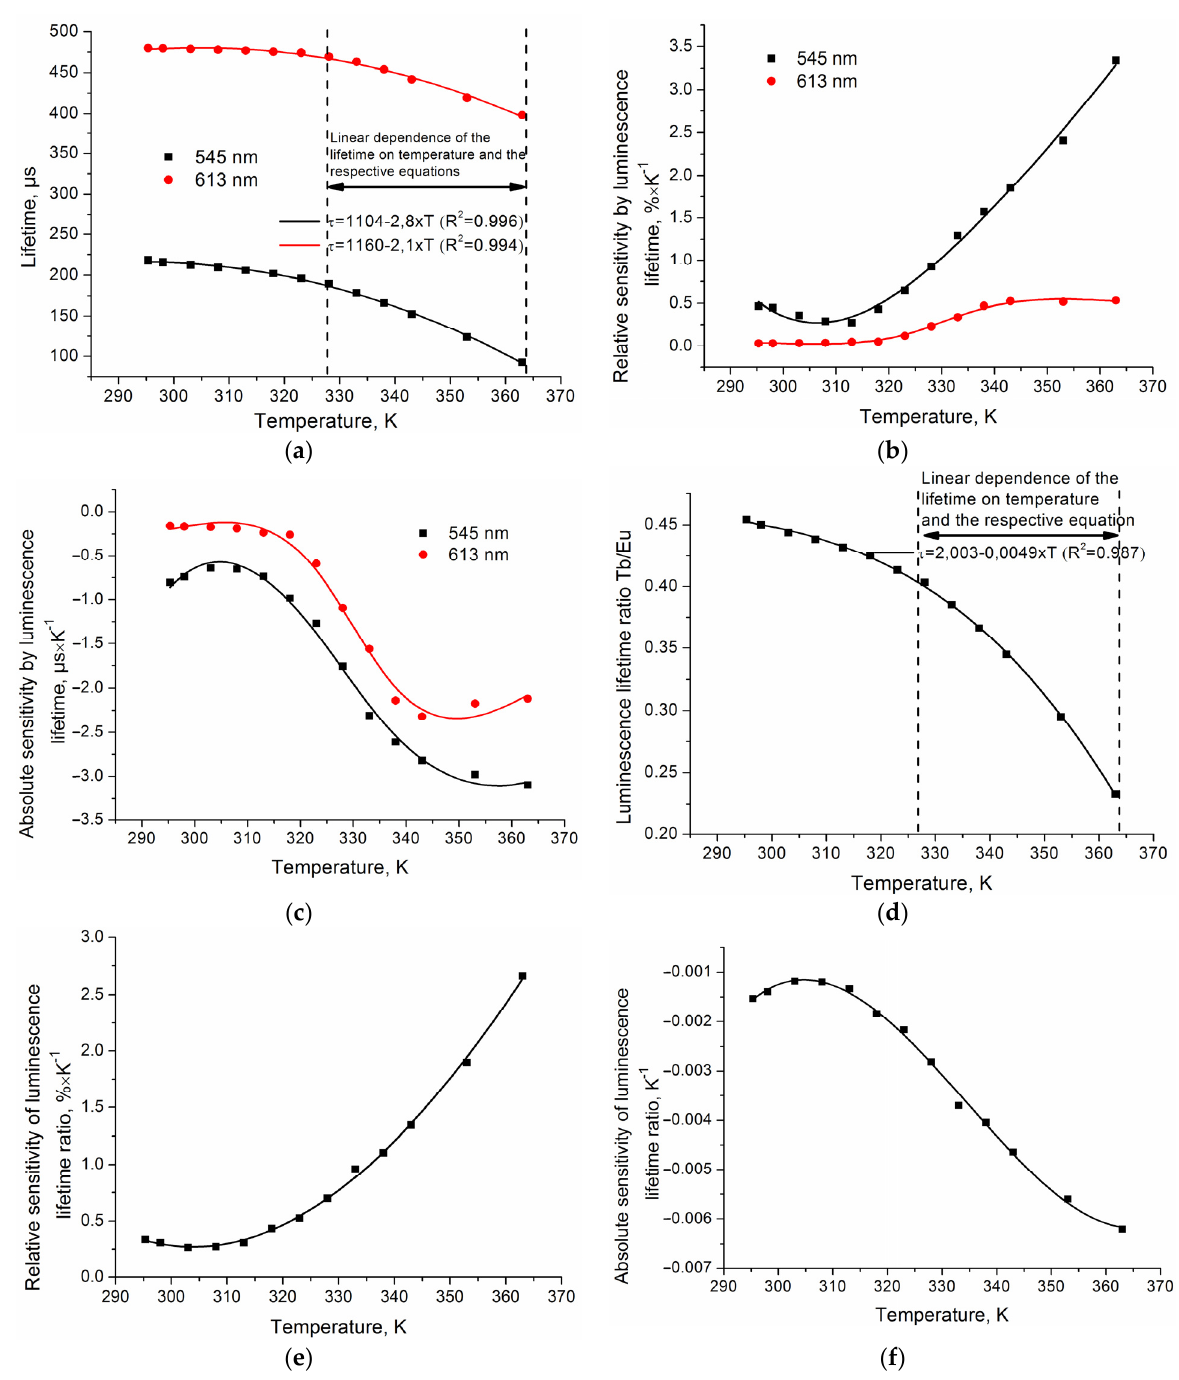
Figure 7. Temperature dependences of the luminescence lifetime ( a ), relative sensitivity of lifetime ( b ), absolute sensitivity of lifetime ( c ), the ratio of lifetimes of the 5 D 4 → 7 F 5 (Tb(III), 545 nm) and 5 D 0 → 7 F 2 (Eu(III), 613 nm) transitions ( d ), the relative sensitivity of the lifetime ratio ( e ), and the absolute sensitivity of the lifetime ratio ( f ) of the 3%Eu5%Tb composite film at λ ex = 330 nm. In the range of 303–363 K, the luminescence lifetime of the samples decreases almost linearly as temperature increases. The slope of the temperature line between 328 K and 363 K is 2.1–2.8 μ s/K (Figure 7b). The maximum relative lifetime sensitivity (Equation (7))